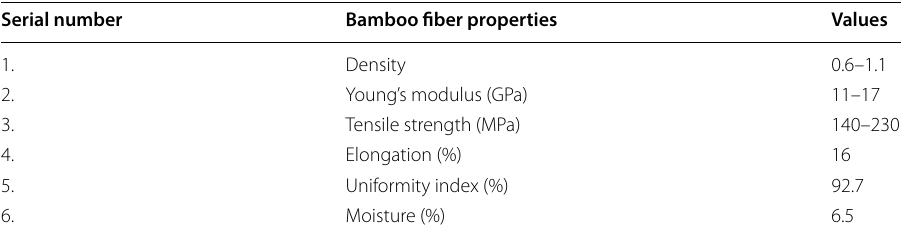
Table 1 Physical properties of bamboo fiber [30, 31, 33]